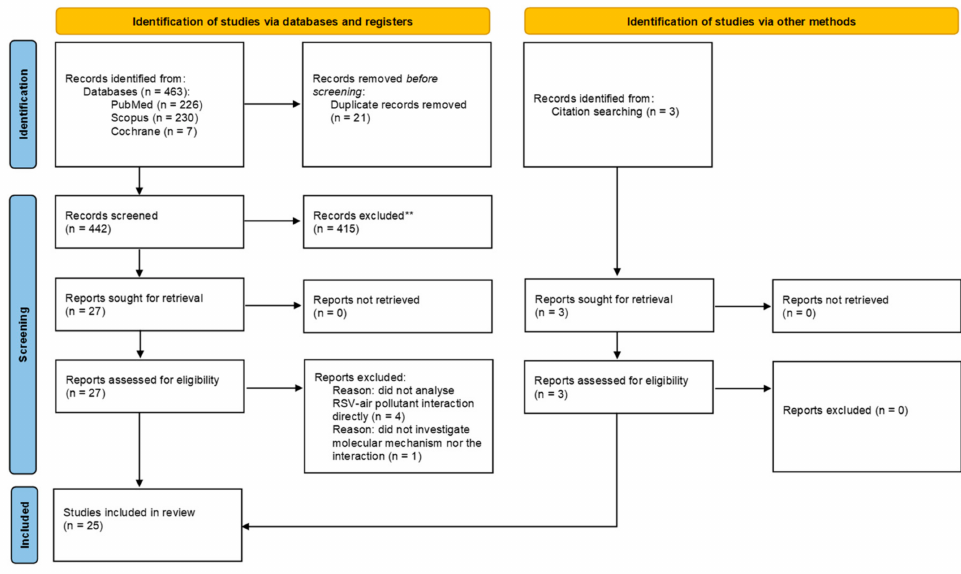
Figure 2. PRISMA flow